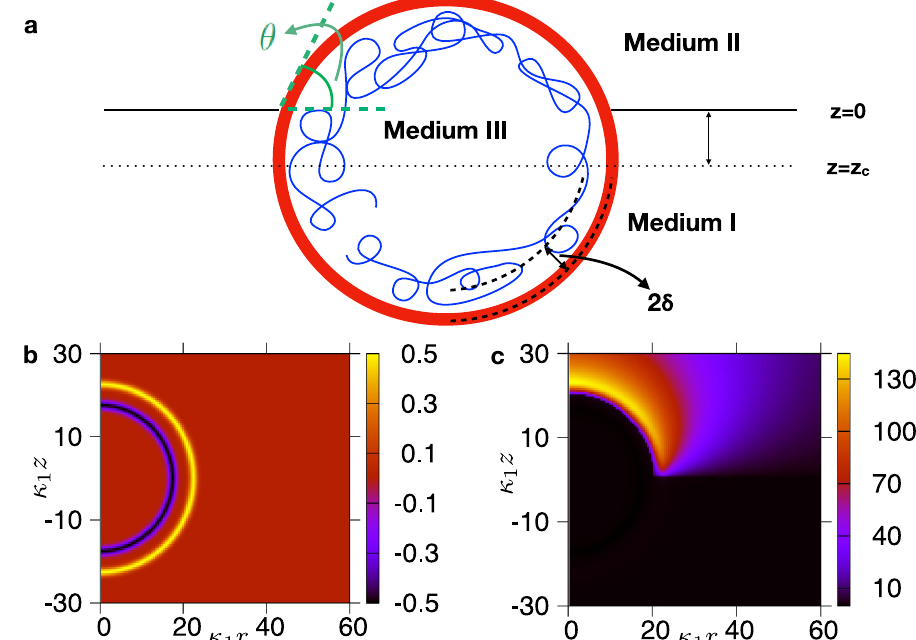
Fig. 1 System set-up and typical pattern of electrostatic potential. a Schematics of the system under consideration. The folded RNA and capsid shell of a virion are modelled as two concentric shells with charge density − σ and σ respectively, a distance 2 δ apart. b Model charge distribution used in numerical simulations of a virion at an air-water interface ( κ 2 / κ 1 = 0, ϵ 2 / ϵ 1 = 1/80, z c = 0). The heat map gives the dimensionless local charge density (see SI, Supplementary Note 1). c Corresponding potential fi eld found by numerically integrating the non-linear PB equation, Eq. (1), for an air-water interface. The heat map gives the value of the dimensionless electrostatic potential ~ ϕ